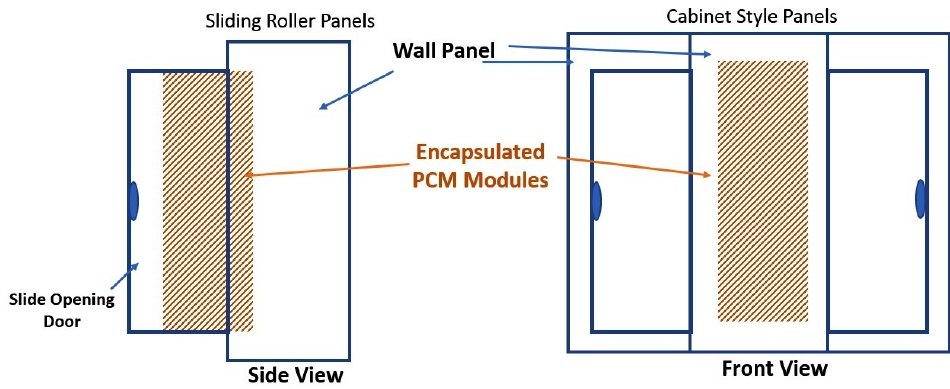
Figure 6. Schematic Drawing of Roller PCM Wall Panel ( left ) and Cabinet Style Panel ( right ).